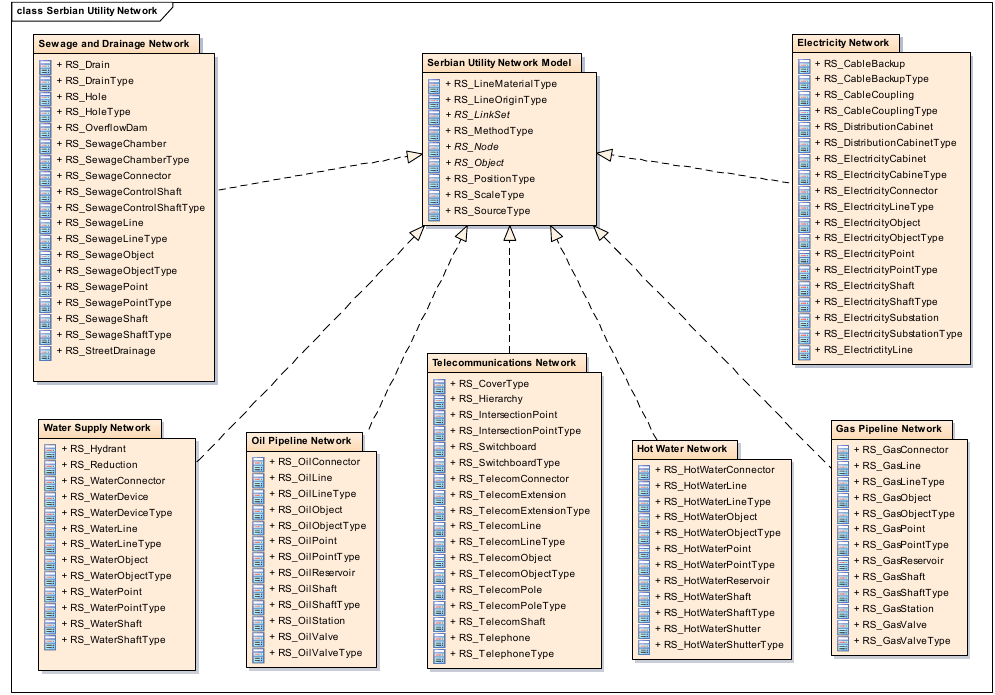
Figure 5. Overview of the utility line networks with the UML (Unified Modeling Language) structure and dependencies.